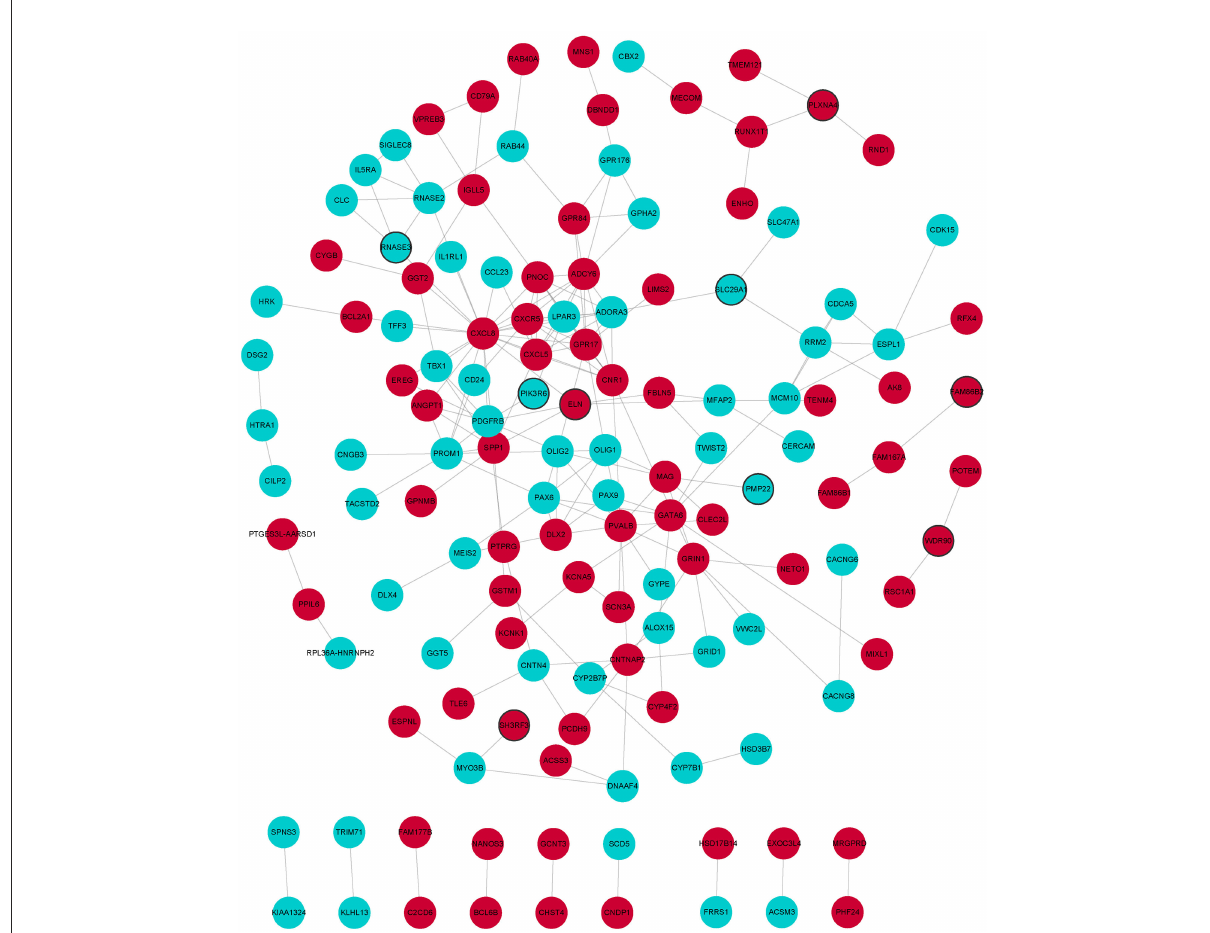
FIGURE3 PPI network of DEmRNAs. Red and wathet represent upregulation and downregulation of DEmRNAs. Black borders represent the top 10 up-/downregulated DEmRNAs.